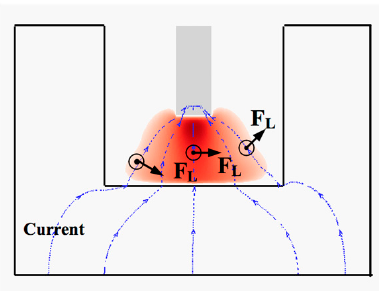
Figure 4. Distribution of Lorentz force from the extra longitudinal magnetic field (LMF).